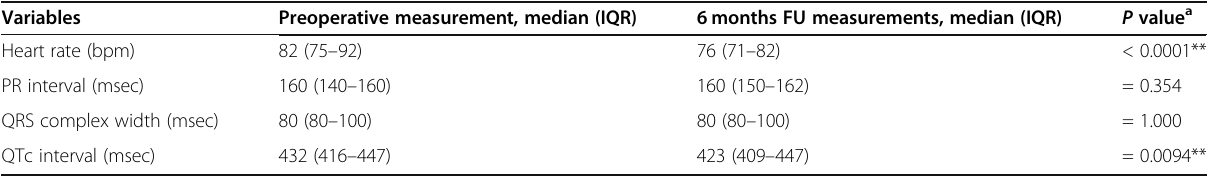
Table 3 Electrocardiographic findings preoperative and 6 months after bariatric surgery Variables